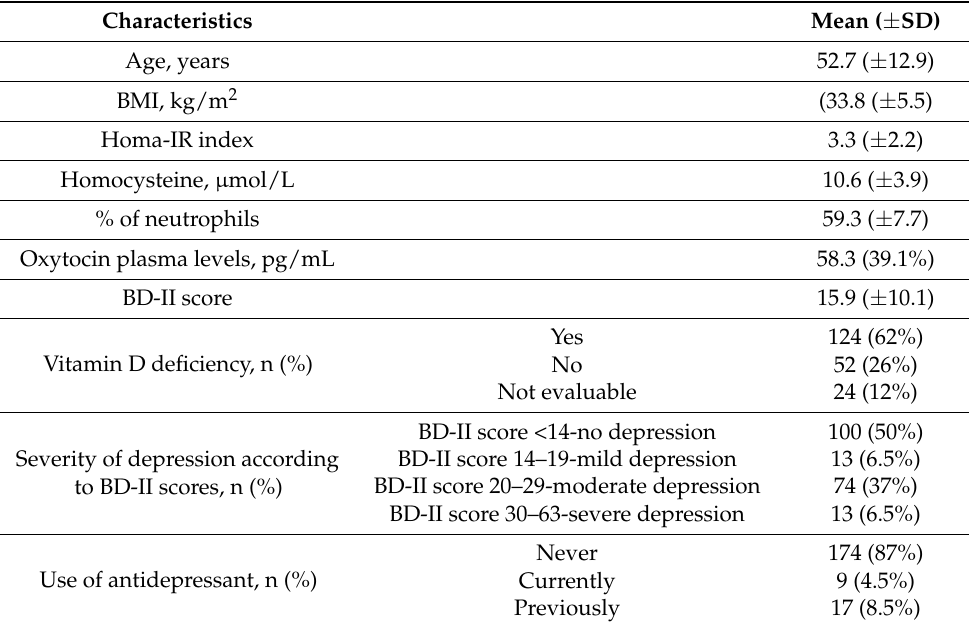
Table 1. Characteristics of the study participants (N =